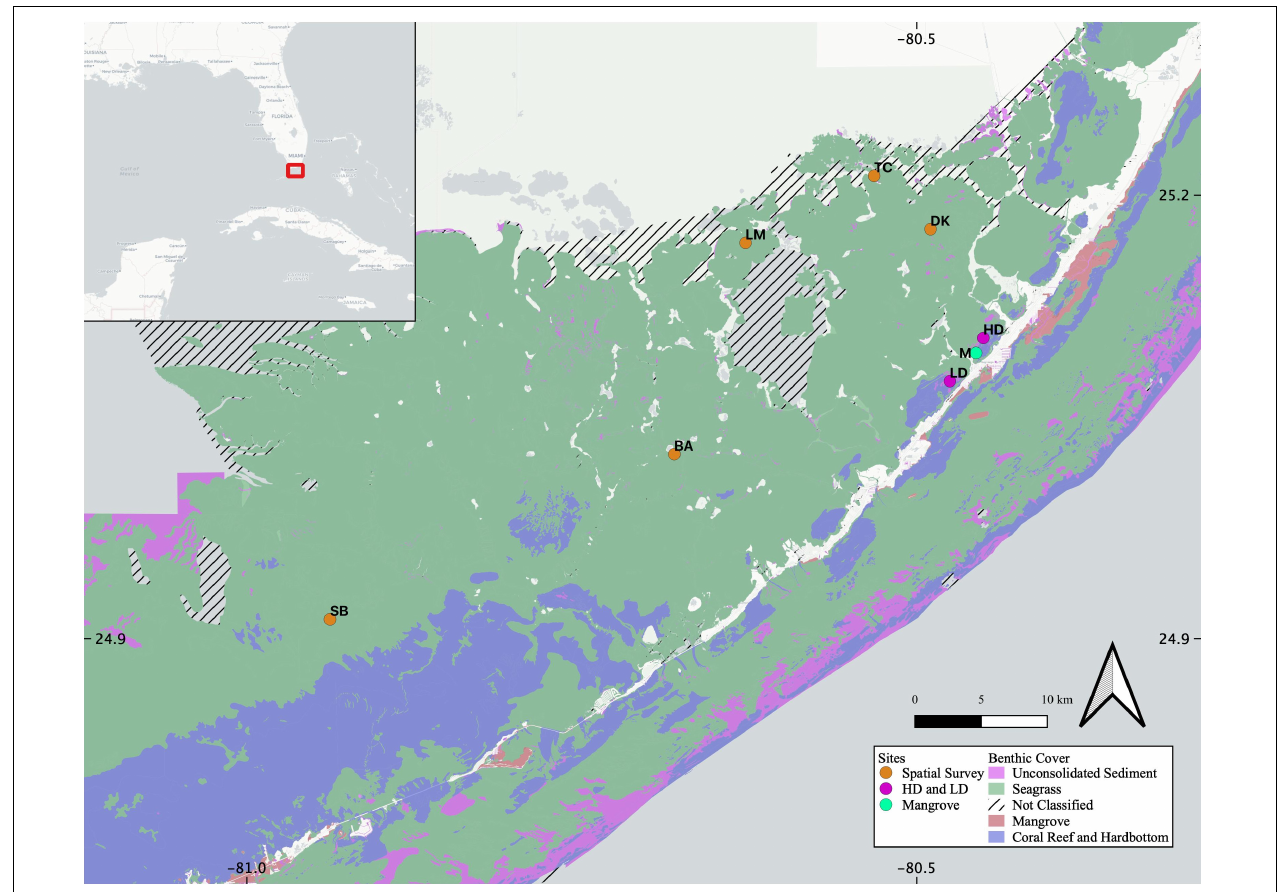
FIGURE 1 | Site map, including the location of the study area within the broader southeastern United States (inset, red box). High density (HD) and low density (LD) seagrass sites were sampled for the diel portion of the study, as well as sediment and seagrass leaching. The Mangrove site (M) was sampled for surface water comparison. The five additional sites sampled for porewater, surface water, and sediment leaching comparisons cover the entire range of Florida Bay (DK, TC, LM, BA, and SB). Benthic coverage data was acquired from the Florida Fish and Wildlife Conservation Commission- Fish and Wildlife Research Institute (FWRI FWC), Unified Reef